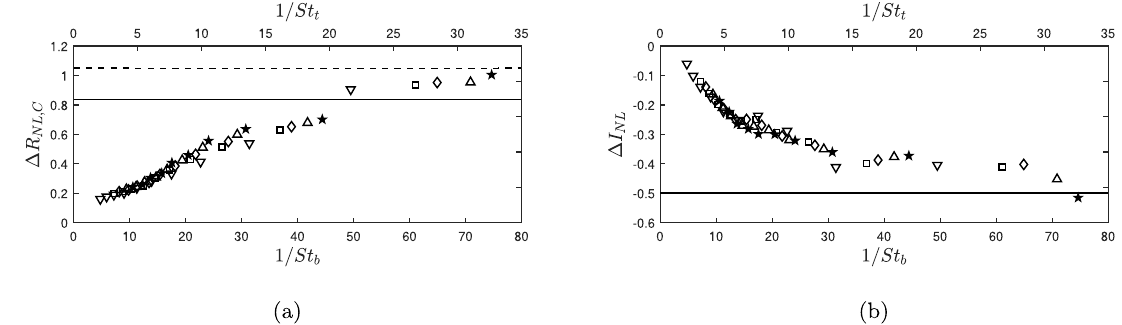
Figure 8. Change in a) slit resistance and b) slit inertance due to non-linearity for long slits as function of St b and St t for several amplitudes at the reference microphone: 10 Pa ( 4 ), 15 Pa ( h ), 17 Pa ( } ), 20 Pa ( 4 ), 23 Pa ( H ). In a) quasi-steady potential fl ow theory ( –– ) and quasi-steady potential fl ow theory corrected for the effect of quasi-steady viscous boundary layer (- - - -); in b) Limit proposed by Ingard and Ising [21] ( –– ).